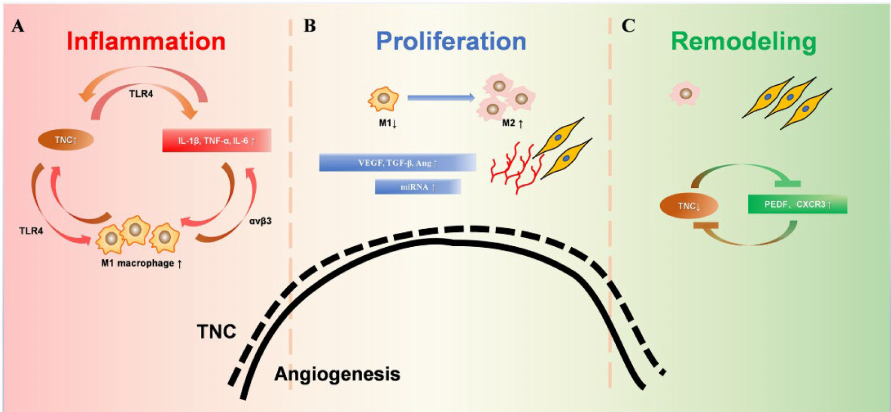
Figure 2. Dynamic changes of TNC during wound healing. ( A ). During the inflammatory phase, TNC induces the synthesis of proinflammatory cytokines through TLR4. TNC enhanced the M1 macrophage polarization of bone-marrow-derived macrophages. Furthermore, proinflammatory cytokines up-regulated the expression of TNC significantly, which amplifies inflammatory responses by creating a positive feedback loop. ( B ). The proliferative phase is mainly granulation tissue, including a large number of new capillaries, fibroblasts, and M1 and M2 macrophages. The substantial increase in TNC promotes angiogenesis, accompanied by promotion of macrophage polarization into the M2 phenotype. Increased M2 phenotype macrophages promote collagen formation and extracellular matrix proliferation. ( C ). During the remodeling stage, the decreased TNC expression leads to decreased M2 phenotype macrophages. Increased fibroblasts and collagen fiber formation are involved in tissue remodeling. Capillaries atrophy and decrease, and TNC decreases to the pre-injury